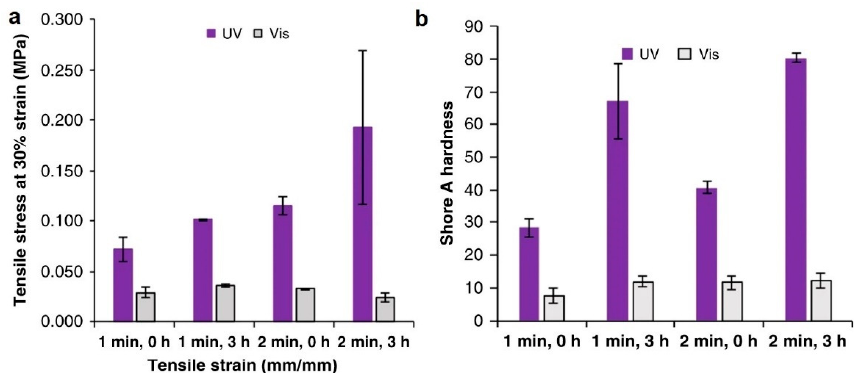
Figure 46. ( a ) Tensile stress values at 30% strain for UV and vis-light cured samples; ( b ) Shore A hardness of UV and vis-light cured samples. Time in minutes represents illumination times and time in hours represents times of thermal post-curing [320].